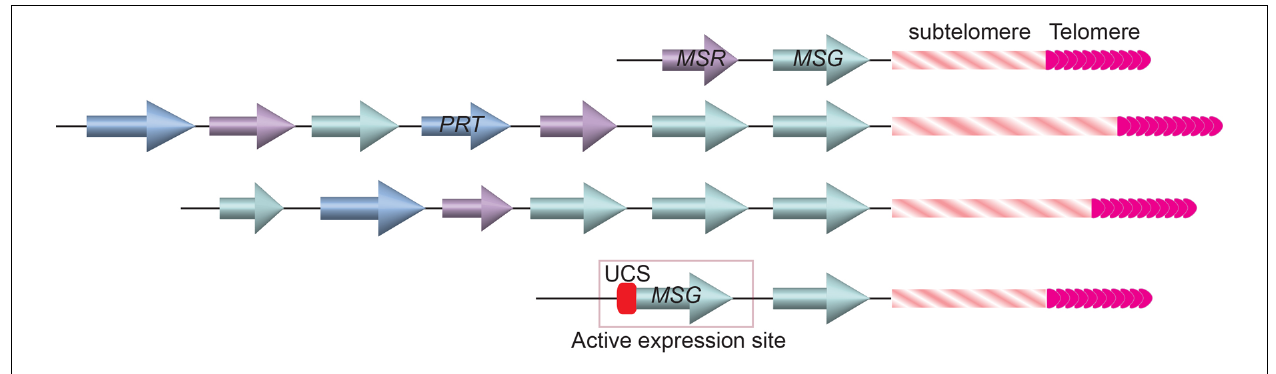
FIGURE 5 | Gene arrays at the ends of three Pneumocystis carinii chromosomes. MSG genes (cyan colored arrows) are located closest to the